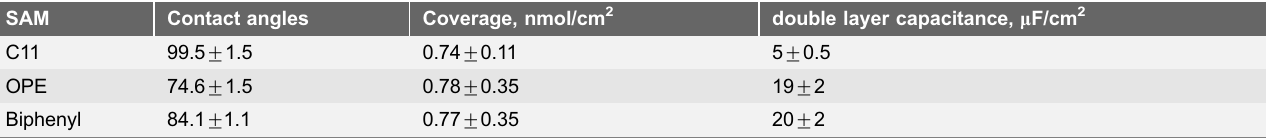
Table 1. Characteristics of SAMs on gold a .